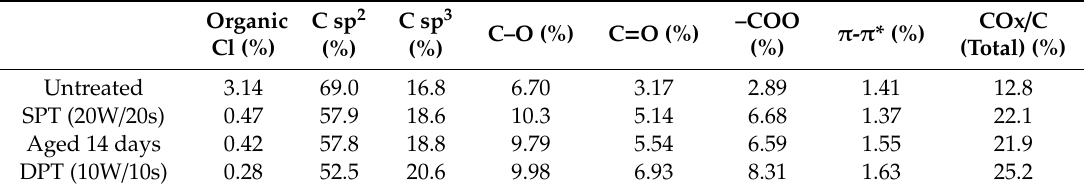
Figure 4. ( a ) Chloride 2p and carbon 1s peak shapes in the deconvoluted X-ray photoelectron spectroscopy (XPS) spectrum and ( b ) variations in atomic percent of the organic chloride and carboxyl groups. Table 2. Variation in the composition of various SWCNTs confirmed by XPS spectra. Note that the optimized condition of the DPT process is effective only if the SPT-SWCNT electrode is aged under aerobic condition for 14 days.